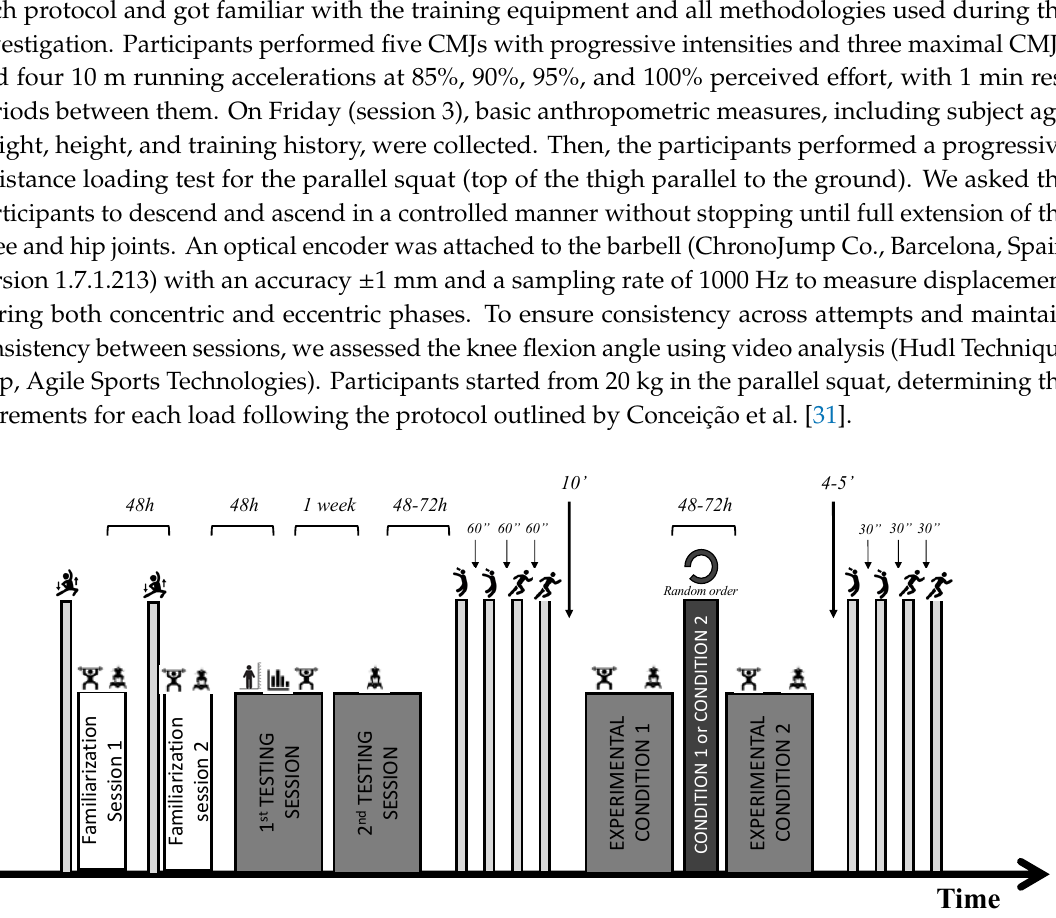
Figure 1. Schematic representation of the study design. : warm up; : parallel squat exercise;